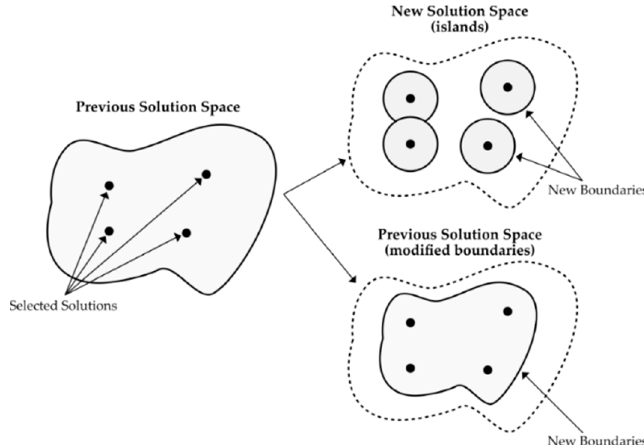
Figure 8. Two approaches to modifying the solution space based on user preferences: creating islands surrounding each selected solution, or creating a modified boundary based on all selected solution.